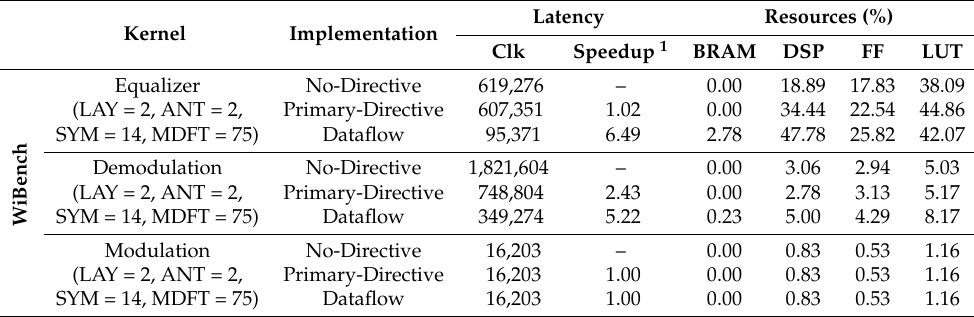
Table 1. Latency and resource utilization of different kernels of PHY-Bench and WiBench benchmark suites on the PL part of Ultrascale+ Zynq with